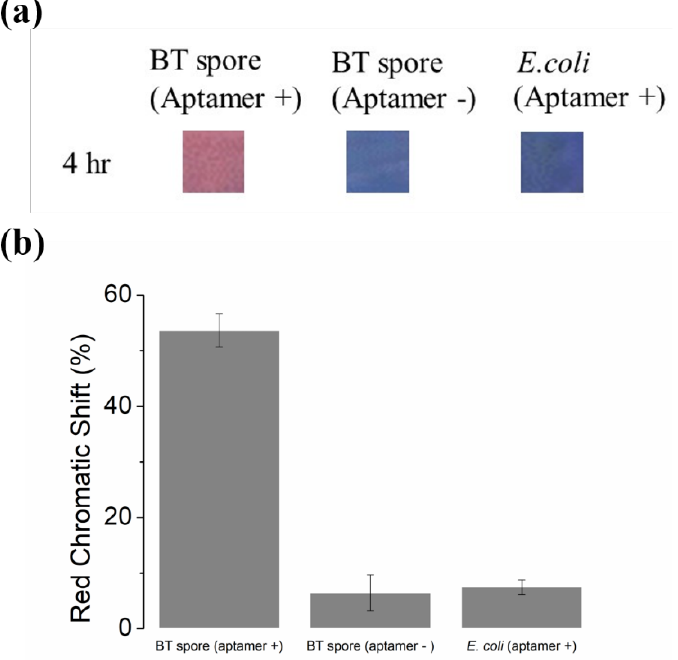
Figure 4. Testing the specificity of the PDA strips. ( a ) Images of the paper strips (with aptamer) after incubation in 3 × 10 11 CFU / mL BT spore solutions, paper strip (without aptamer) in 3 × 10 11 CFU / mL BT spore solution, and paper strip (with aptamer) in 3 × 10 11 CFU / mL E. coli for 4 h. The negative and positive control images are strips dipped in PBS (5 mM, pH = 7.5) and 1 M NaOH. ( b ) Red chromatic shift of the strips after 4 h of incubation. Red chromatic shift data are presented as the mean ± SD (n = 3).